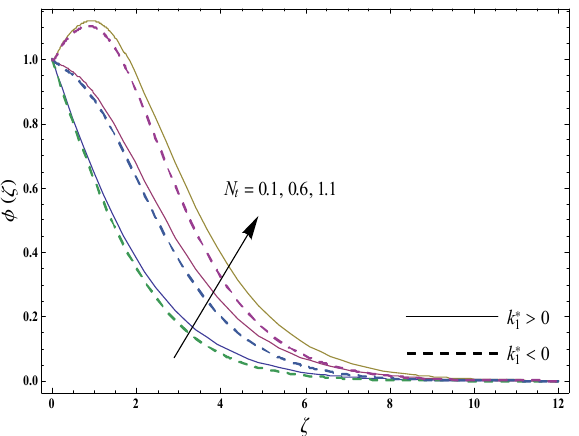
Figure 8. Variations of concentration for Brownian motion parameter when N t = 0.1, Sc = Pr = 1.0 and M = 0.2.